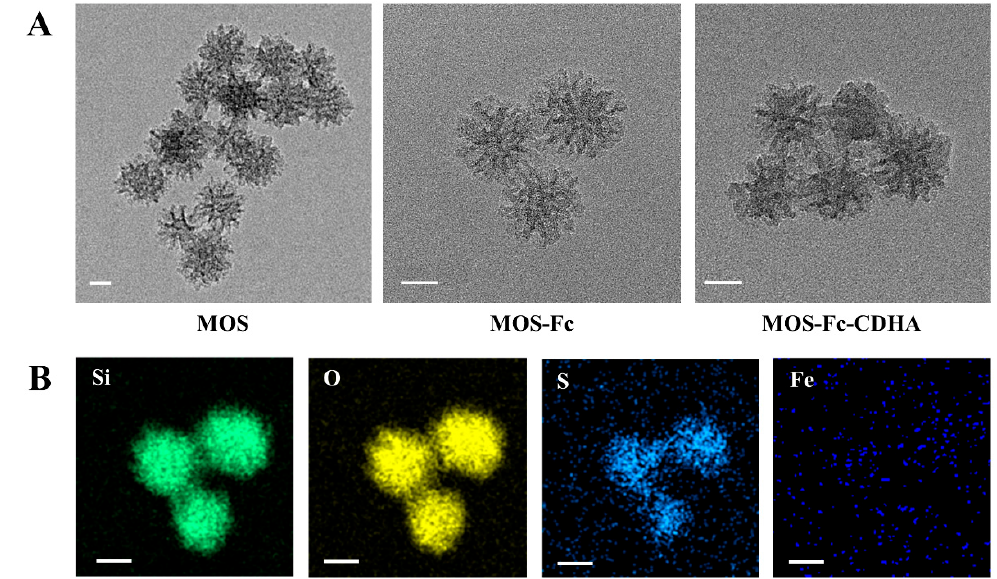
Figure 1. ( A ) TEM images of the MOS, MOS-Fc, and MOS-Fc-CDHA nanocomposites. ( B ) EDX mapping images of the MOS-Fc-CDHA nanocomposites. Scale bars are 20 nm.